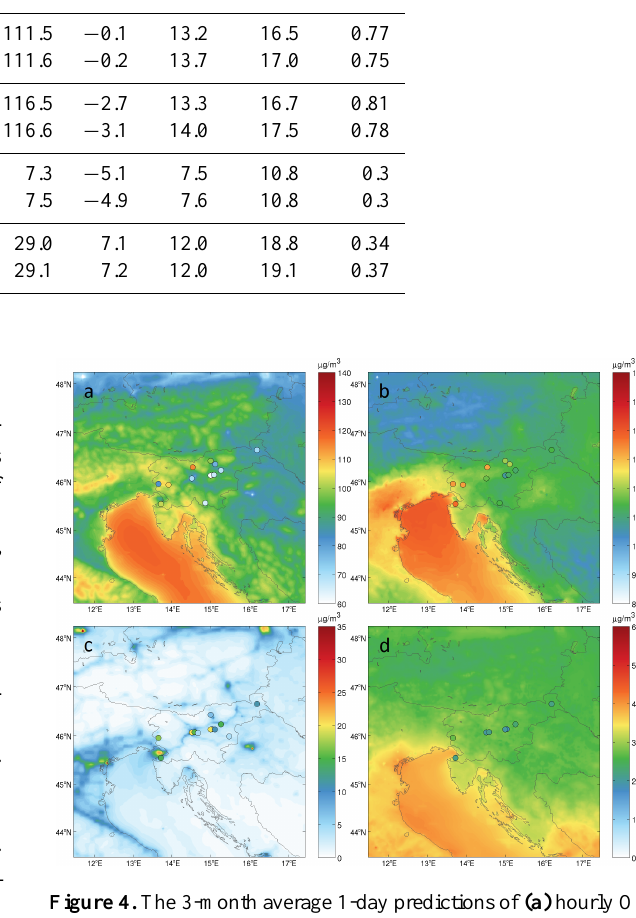
Figure 4. The 3-month average 1-day predictions of (a) hourly O 3 , (b) O 3 daily maximum, (c) hourly NO 2 , and (d) daily PM 10 con- centrations for the first model layer, overlaid with